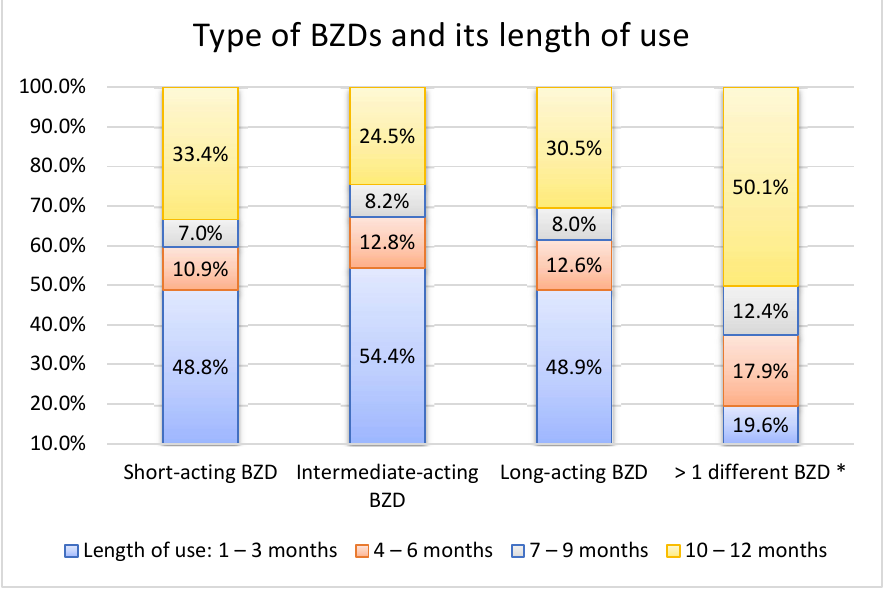
Figure 1. Length of use depending on the type of benzodiazepine (BZD). * A significant number of patients had used different types of BZDs during the surveyed time period.